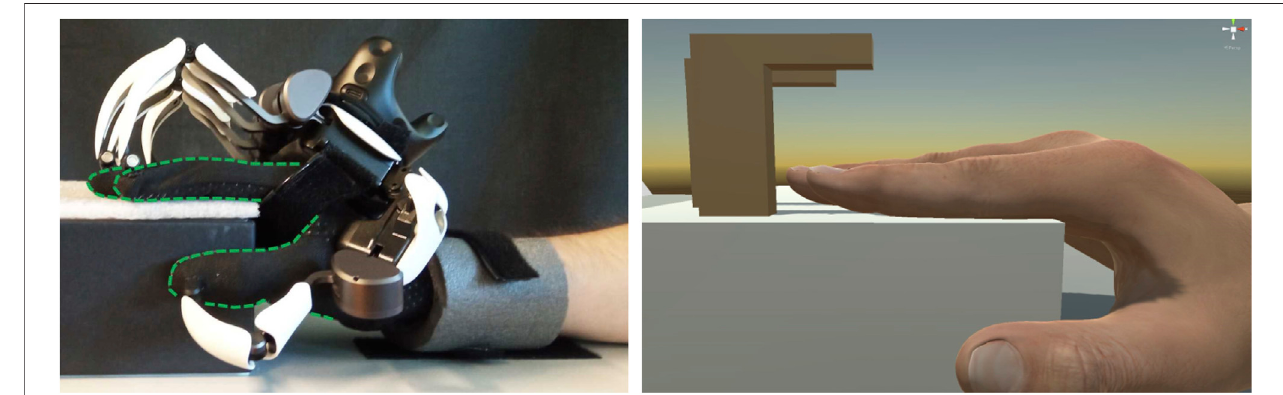
FIGURE 2 | Participant ’ s real hand (outlined in green) and corresponding virtual hand.